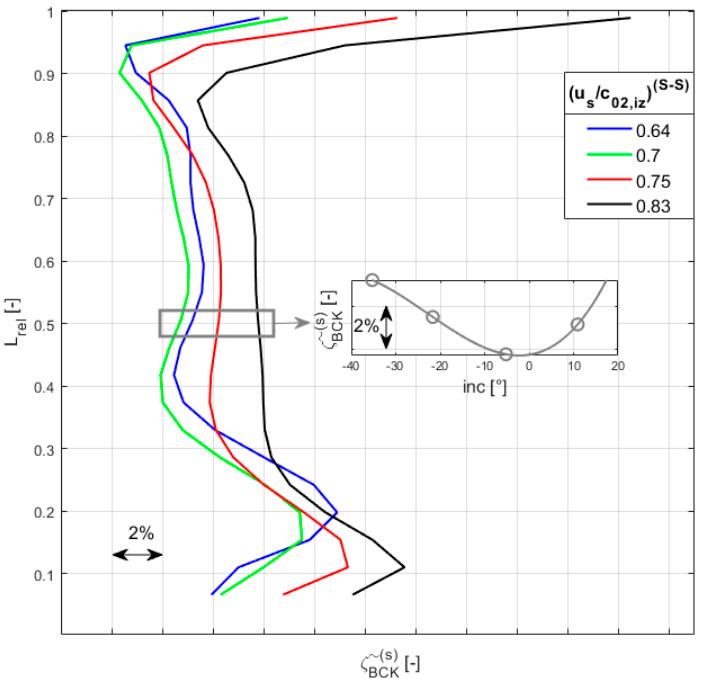
Figure 11. Pitchwise-mass-averaged entropy generation loss coefficients radial distribution.